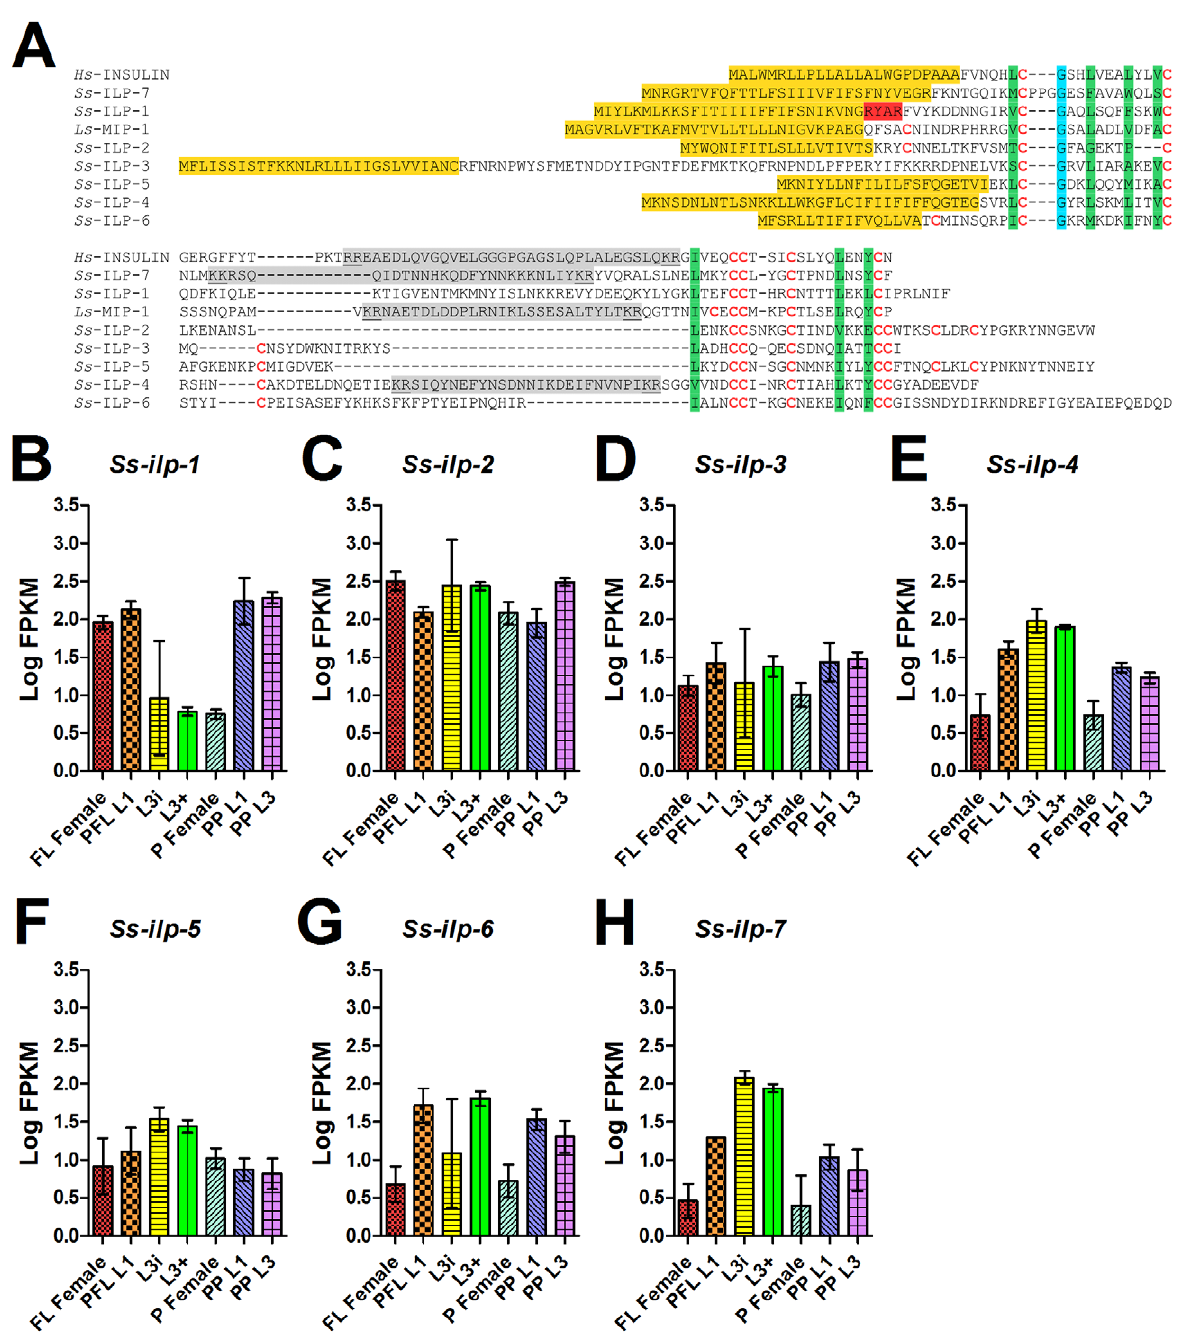
Figure 5. Protein sequence diversity and temporal regulation of S.stercoralis insulin-like peptides. (A) A predicted protein sequence alignment of seven S. stercoralis insulin-like peptides (ILPs), Ss -ILP-1 through -7, was constructed using human insulin ( Hs -INSULIN) and Lymnaea stagnalis molluscan insulin-related peptide I ( Ls -MIP-1) as the references. Cysteine residues, which are predicted to form disulfide bonds, are in red letters. Predicted signal sequences are highlighted in yellow, predicted furin recognition motifs are highlighted in red, hydrophobic residues important for helix formation are highlighted in green, and a conserved glycine is highlighted in blue. Predicted C peptides are highlighted in gray with dibasic predicted cleavage sites underlined. The B peptide is N-terminal of the C peptide, while the A peptide is C-terminal of the C peptide. (B- H) Transcript abundances were determined for the coding region of seven S. stercoralis ILP-encoding genes ( Ss-ilp-1 through -7 ) in seven developmental stages: free-living females (FL Female), post-free-living first-stage larvae (PFL L1), infectious third-stage larvae (L3i), in vivo activated third-stage larvae (L3 + ), parasitic females (P Female), post-parasitic first-stage larvae (PP L1), and post-parasitic third-stage larvae (PP L3). Transcript abundances were calculated as fragments per kilobase of coding exon per million mapped reads (FPKM) and log transformed. Error bars represent 95% confidence intervals. The y-axes were scaled from 0 to 3.5 to aid comparison between genes.